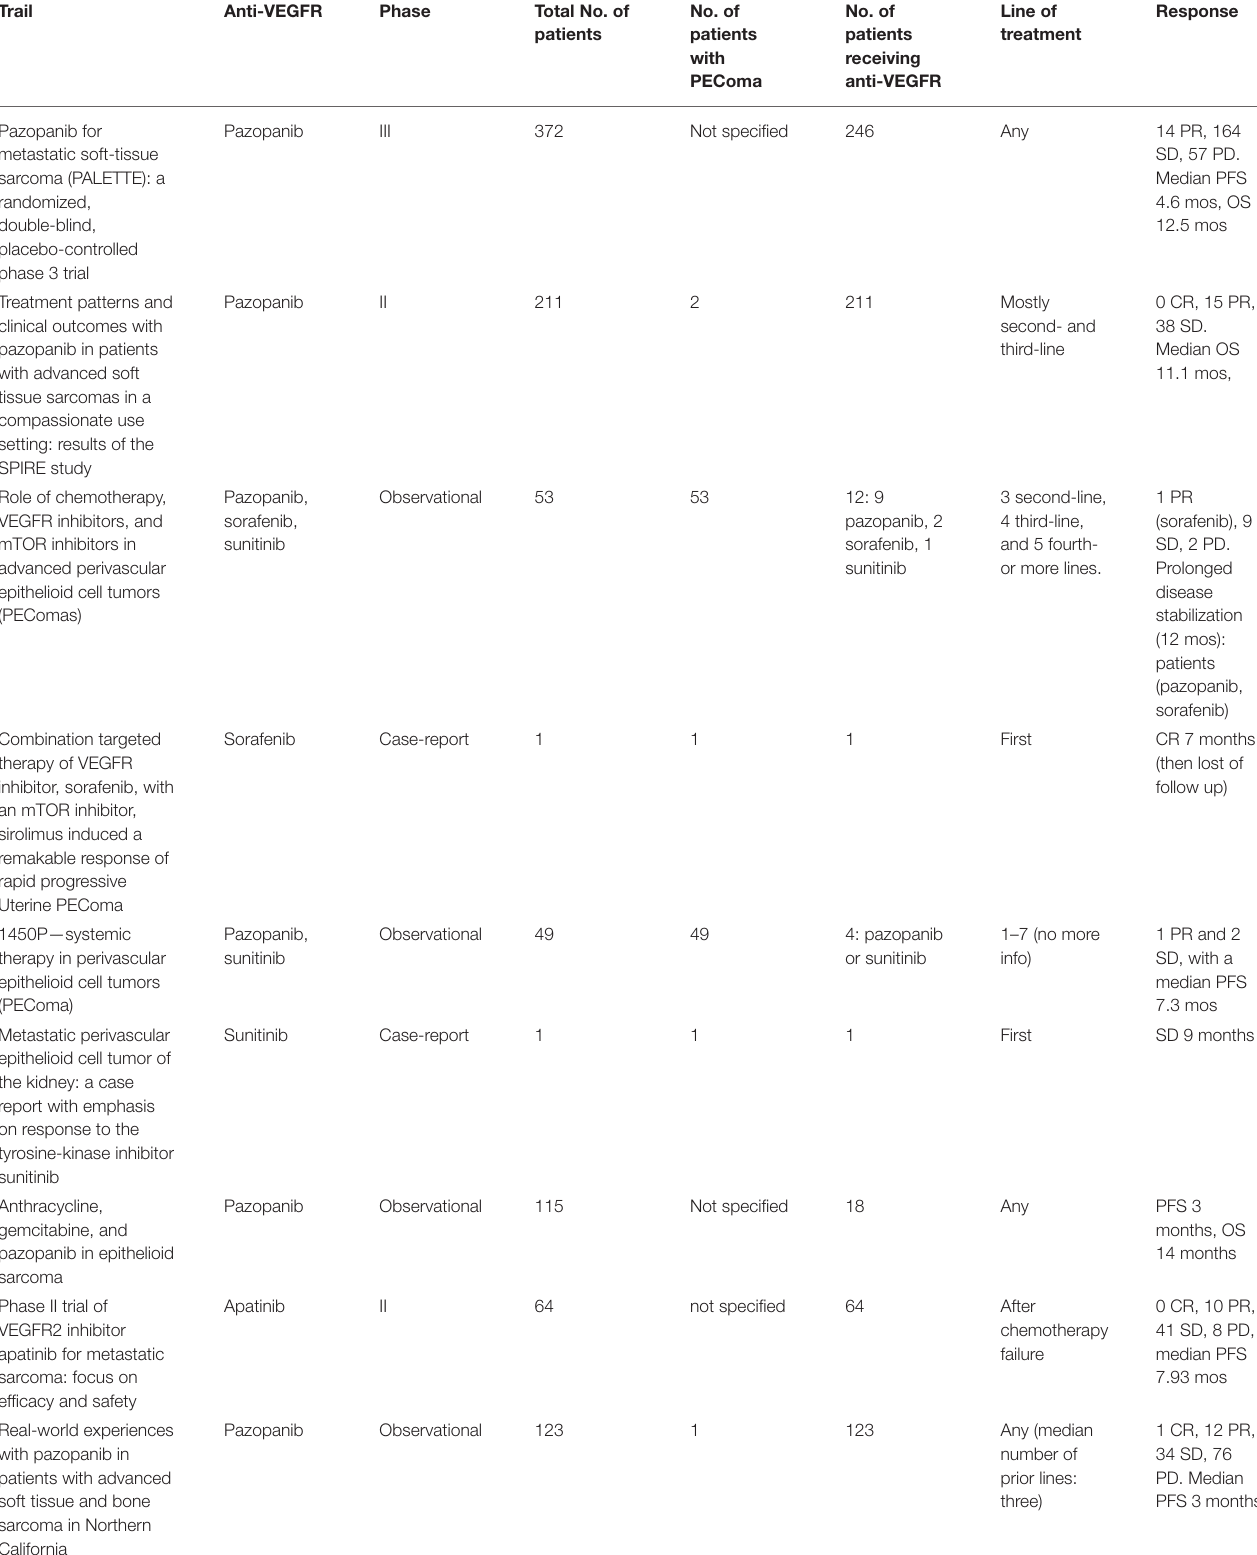
TABLE 1 | Summary of studies evaluating anti-VEGFR treatments for PEComas/soft tissue sarcomas (18–24). Trail Anti-VEGFR Phase Total No. of